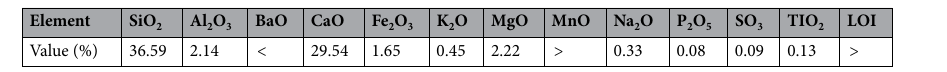
Table 4. The results of XRF analysis of core samples (%).